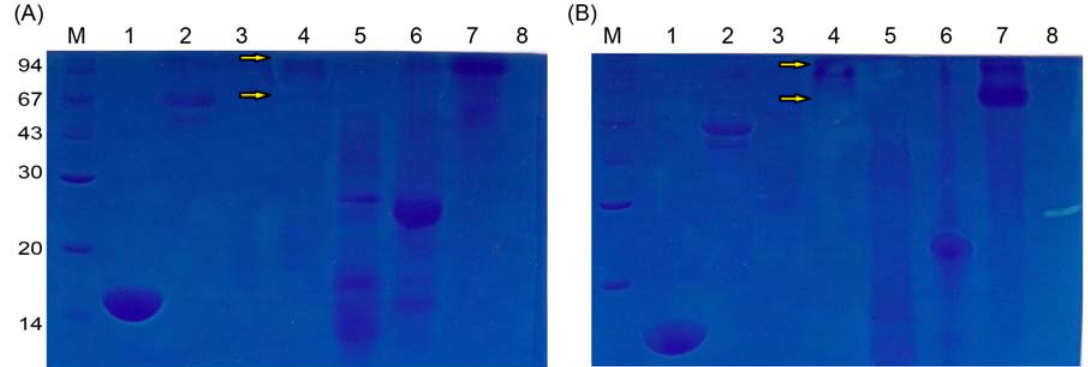
Figure 2. Unusual susceptibilities of chitin ( A ) and chitosan ( B ) to enzymatic hydrolysis demonstrated using the in-gel assay. Lane M, protein markers; Lane 1, lysozyme; Lane 2, cellulose; Lane 3, biopectinase; Lane 4, pancreatin; Lane 5, bromelain; Lane 6, papain; Lane 7, lactase; Lane 8,